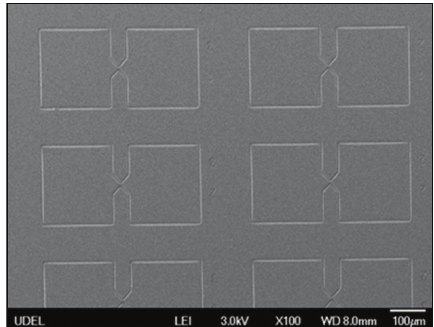
Figure 3: Scanning electron micrograph of an array of tunnel junctions fabricated using ALD